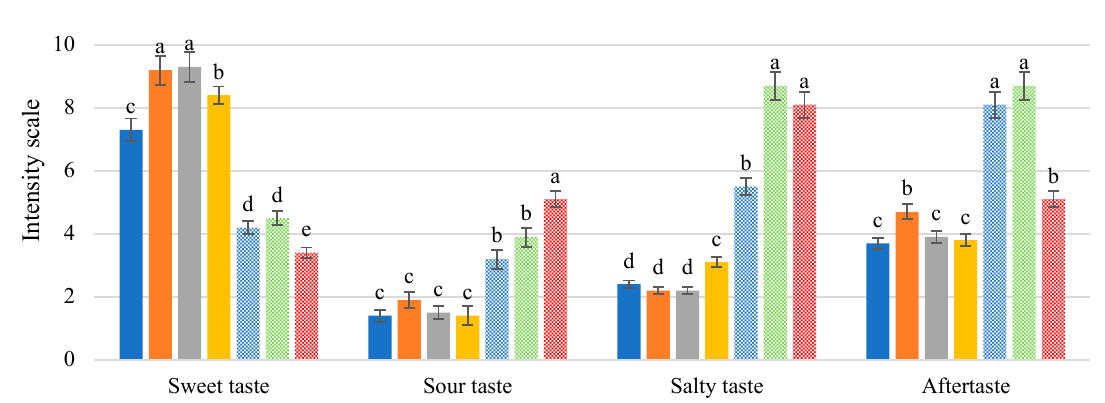
Figure 4. The sensory properties of syrups after two-stage fermentation. Using sweet whey permeate and enzyme 1GYS—GODO-YNL2; 1NFS—NOLA™ Fit5500; 1HLS—Ha-Lactase 5200. Using acid whey permeate and enzyme 2GYA—GODO-YNL2; 2NFA—NOLA™ Fit5500; 2HLA—Ha-Lactase 5200. Control—commercial glucose-galactose syrup. The values marked with the same letter within each sensory attribute do not differ significantly ( p > 0.05) ( n = 30).